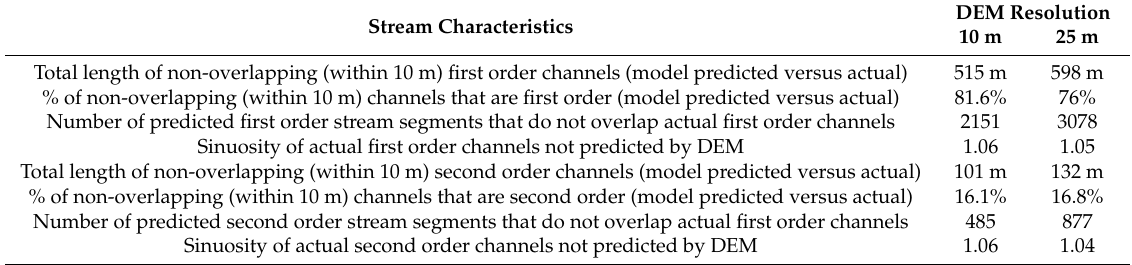
locations of first and second order